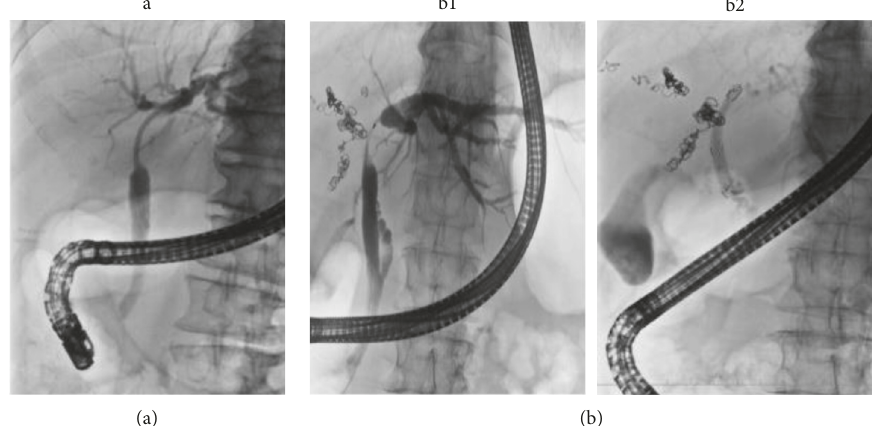
Figure 1: Placement of each stent. (a) The IS case. A patient with Bismuth-Corlette type IIIa PHCC for whom right hepatectomy was the expected surgical operation. Because B2, B3, and B4 confluence almost simultaneously, the IS (7 Fr 9cm deep angle) was placed in the left bile duct. (b) The FCSEMS case. A patient with Bismuth-Corlette type IIIa PHCC for whom right hepatectomy was the expected surgical operation. The cholangiogram shows that the confluence of B4 is more than 5mm from the upper end of the stenosis (b1); FCSEMS (6mm × 4cm) was placed such that B4 was not obstructed (b2). IS, inside stent; FCSEMS, fully covered self-expandable metallic stent; PHCC, perihilar cholangiocarcinoma; B2, left lateral superior segmental bile duct; B3, left lateral inferior segmental bile duct; B4, left medial segmental bile